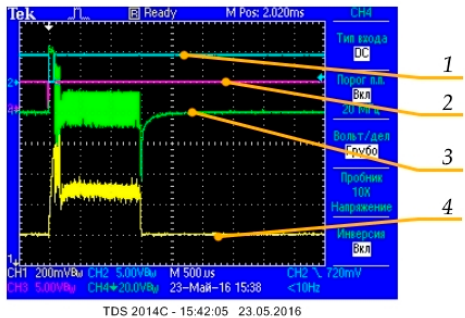
Figure 2. Oscillogram of control of the solenoid injector and high-speed camera: 1—Starting voltage of control unit; 2—control pulse of high-speed camera; 3—voltage on the solenoid valve of injector; 4—output voltage of current transducer LTS 25-NP.